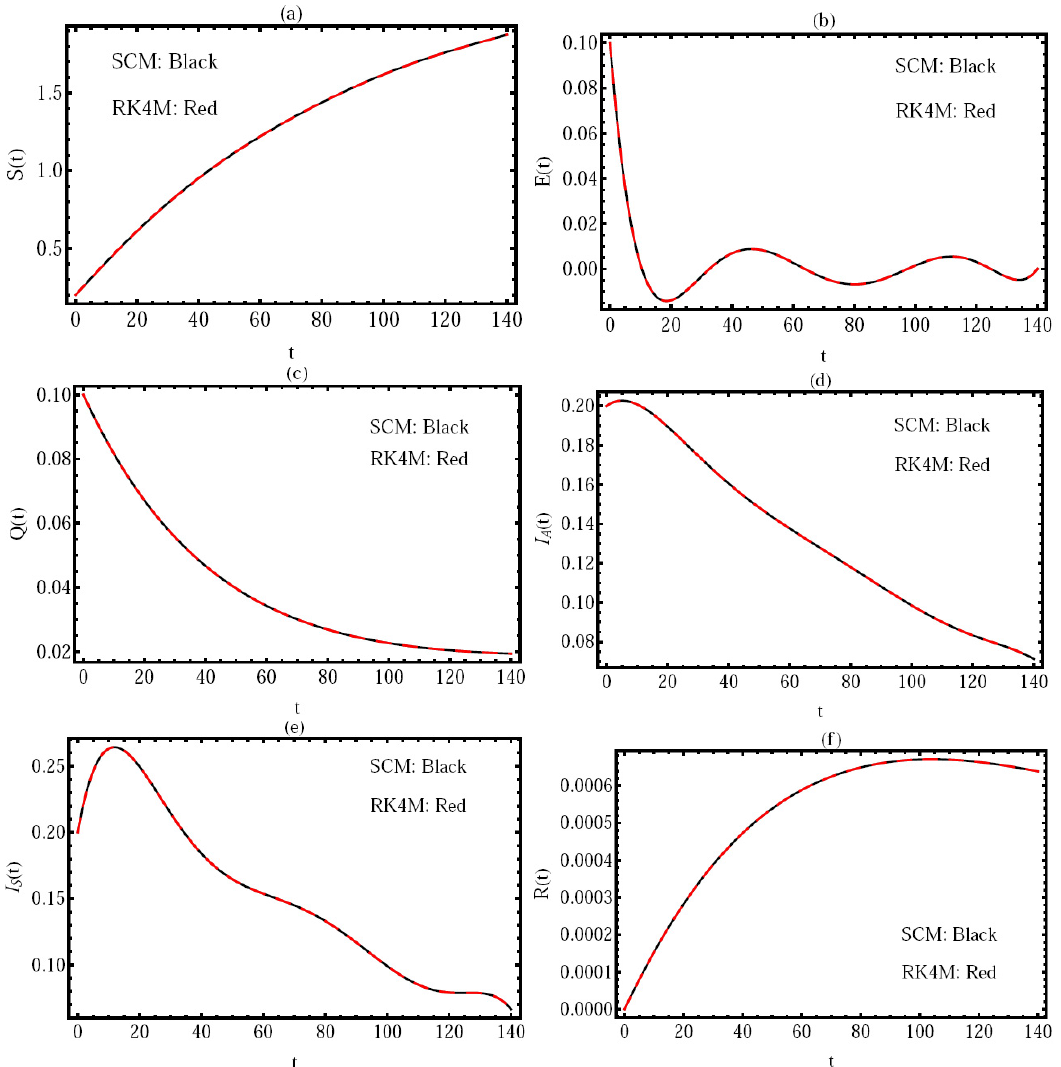
Figure 6. Comparison the solution obtained by the proposed method and the GRK4M method. ( a – f ) S ( t ) , E ( t ) , Q ( t ) , IA ( t ) , IS ( t ) , R ( t )